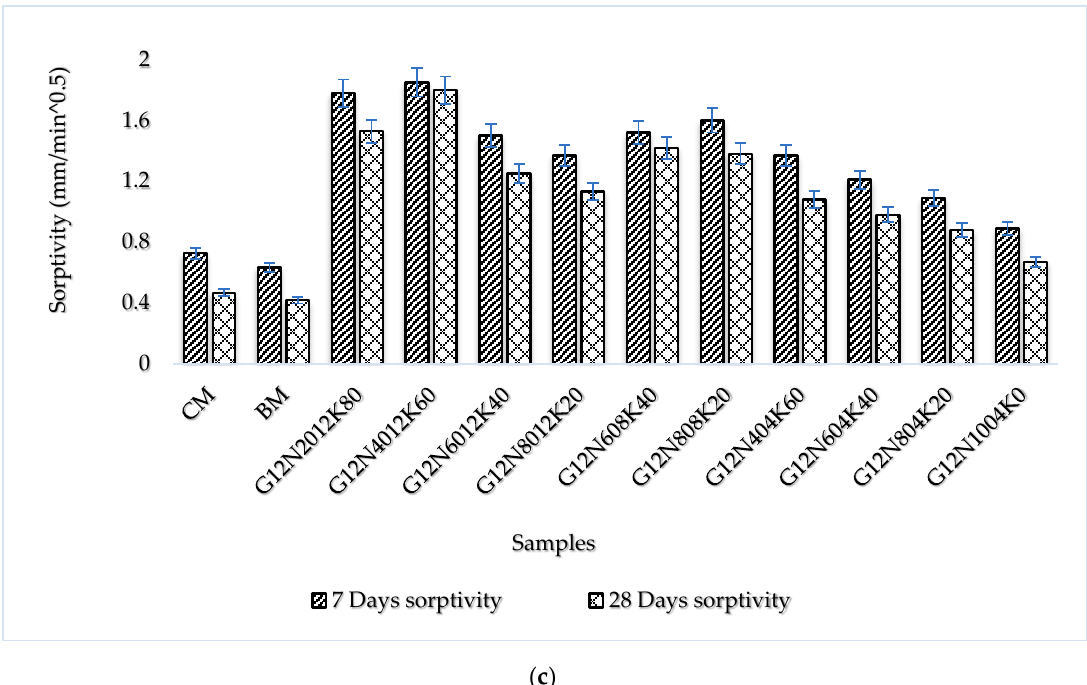
Figure 5. Sorptivity values of geopolymer cement pastes at 7 and 28 days: ( a ) for 4 M samples, ( b ) for 8 M samples, and ( c ) for 12 M samples.